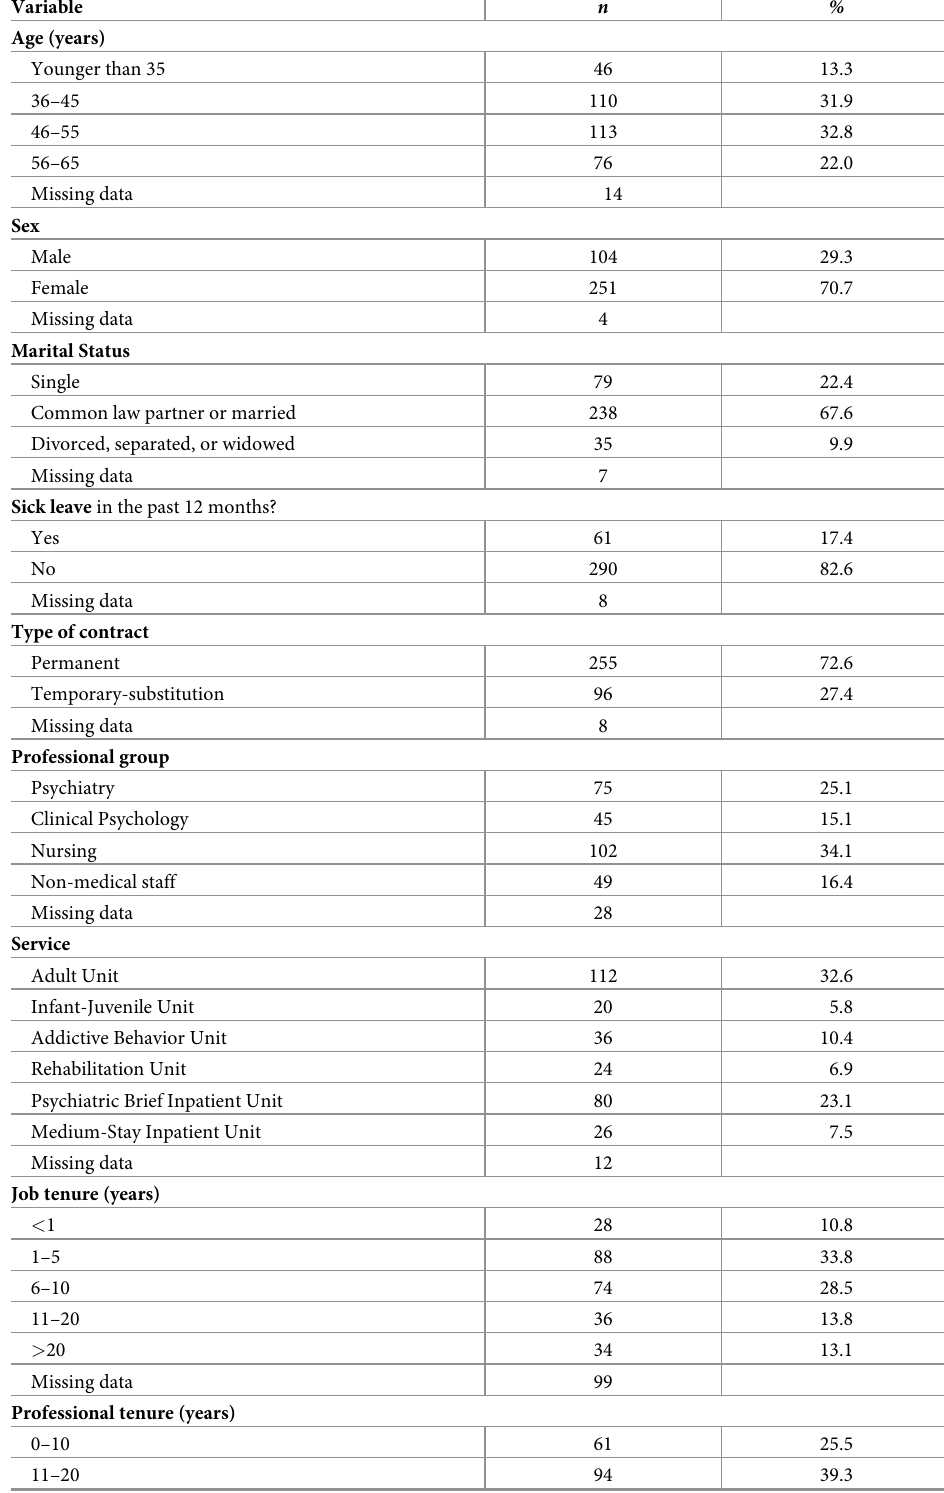
Table 1. Sociodemographic and work characteristics of the